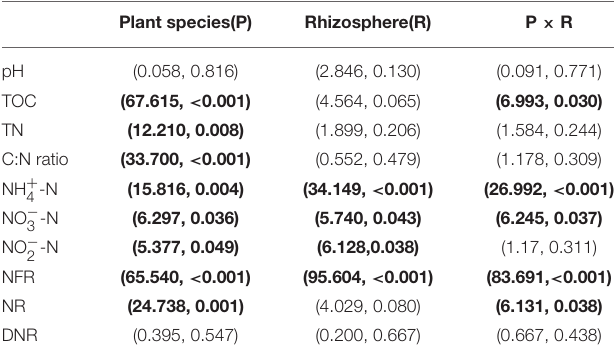
TABLE 2 | Multivariate analysis of variance (MANOVA) ( F -value, P -value) of mixed effects of plant species (P), rhizosphere (R) and their interaction on the chemical properties and nitrogen transformation